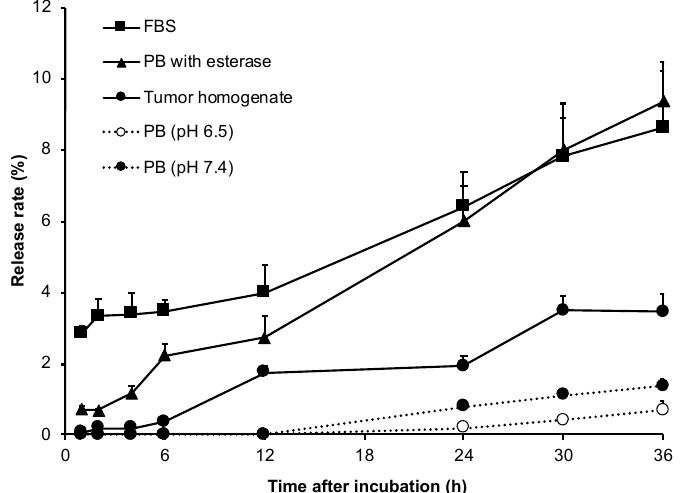
Figure 3. ZnPP release from HA-es-ZnPP at different conditions. In sodium phosphate buffer, almost no ZnPP was released from the conjugate at both physiological pH and weak acidic pH up to 12 h. Much rapid release of ZnPP occurred in presence of either esterase or FBS having esterase activities. A relatively high level of ZnPP release was also found in tumor homogenate.